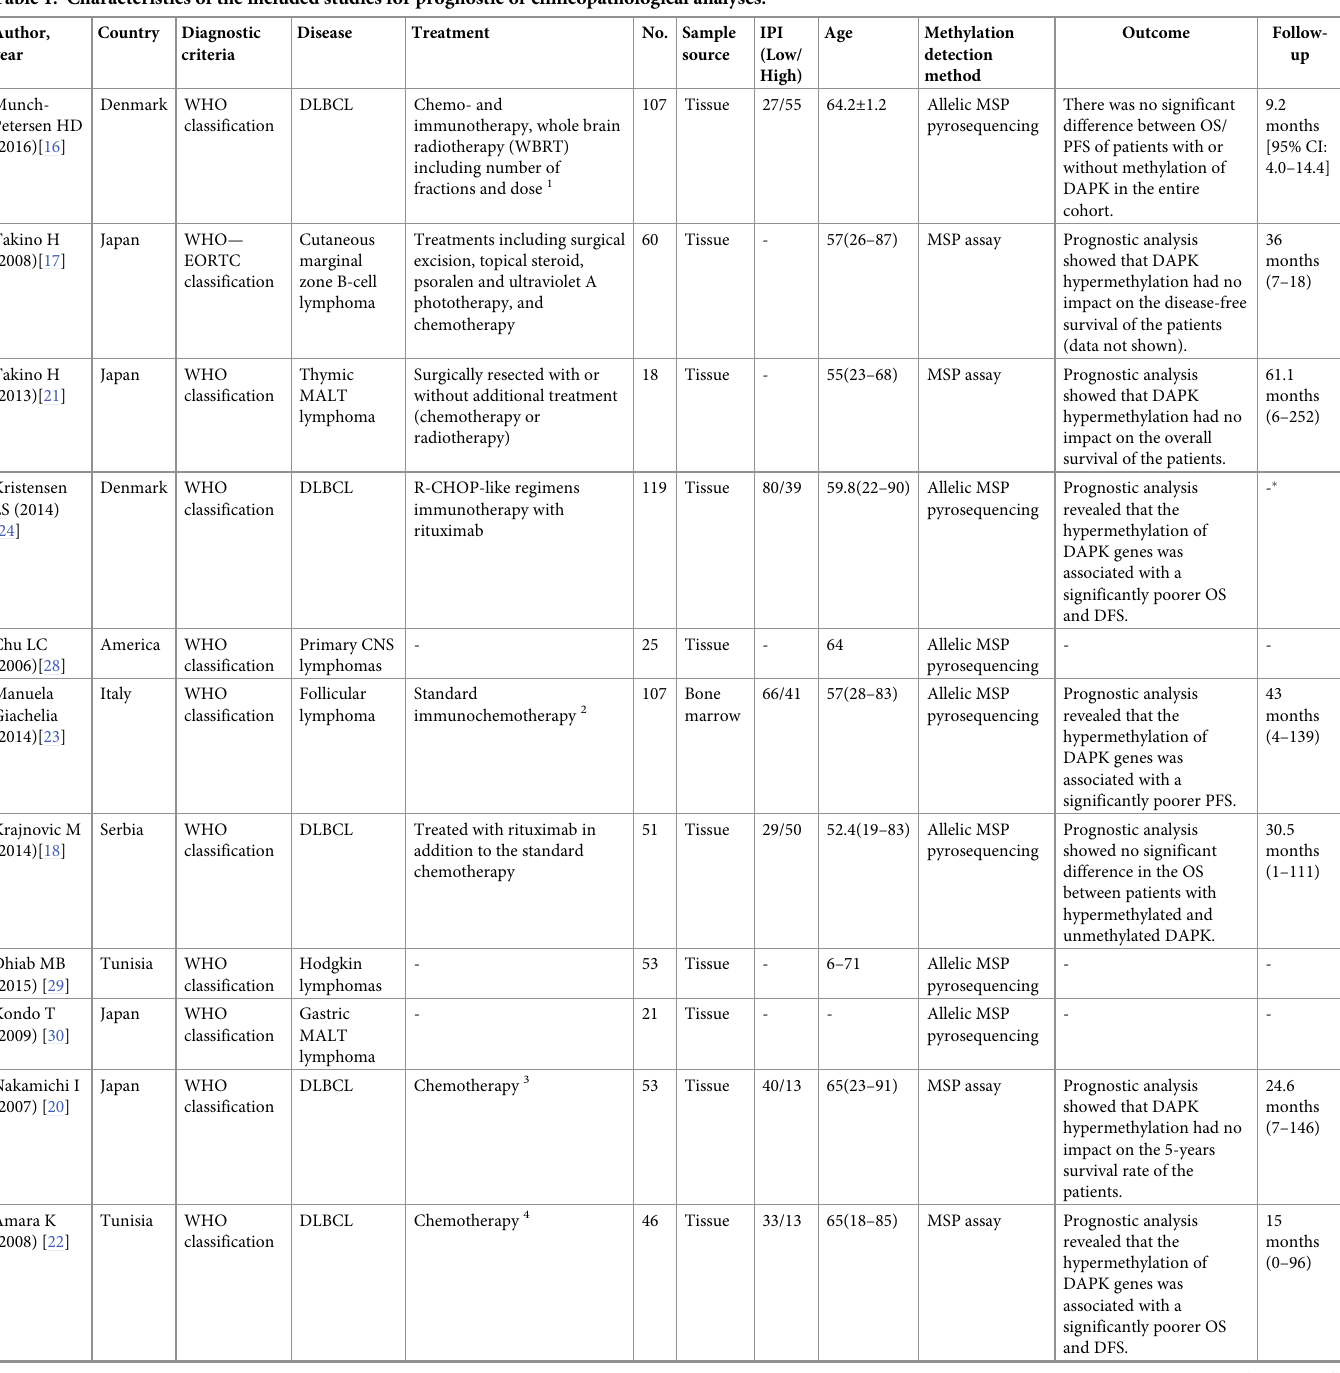
Table 1. Characteristics of the included studies for prognostic or clinicopathological